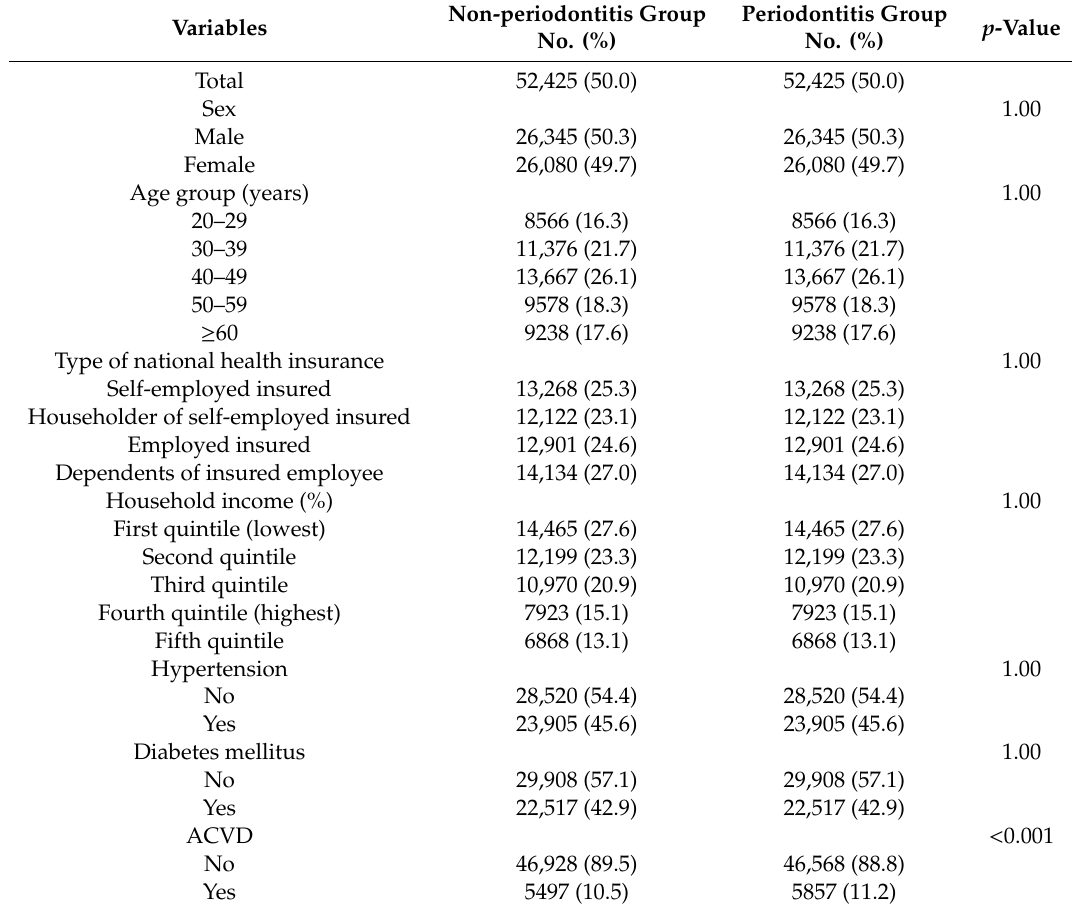
Table 2. Socioeconomic and systemic status of the participants by diagnosis of